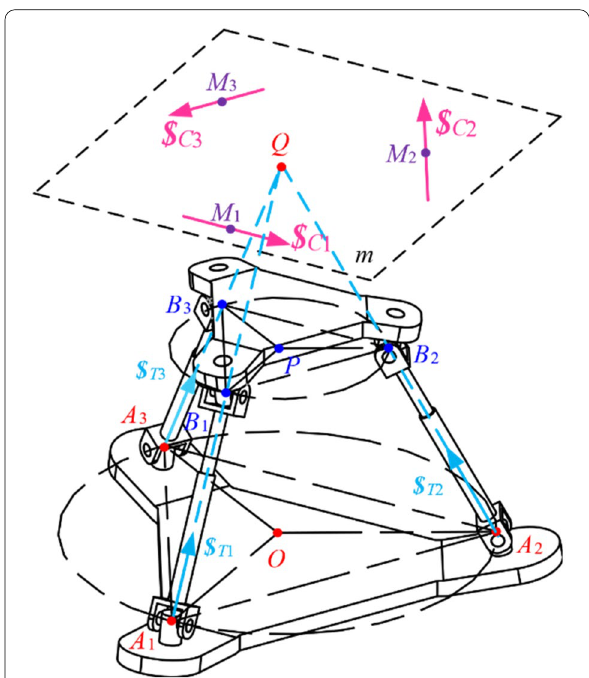
Figure 11 Mixed singularity